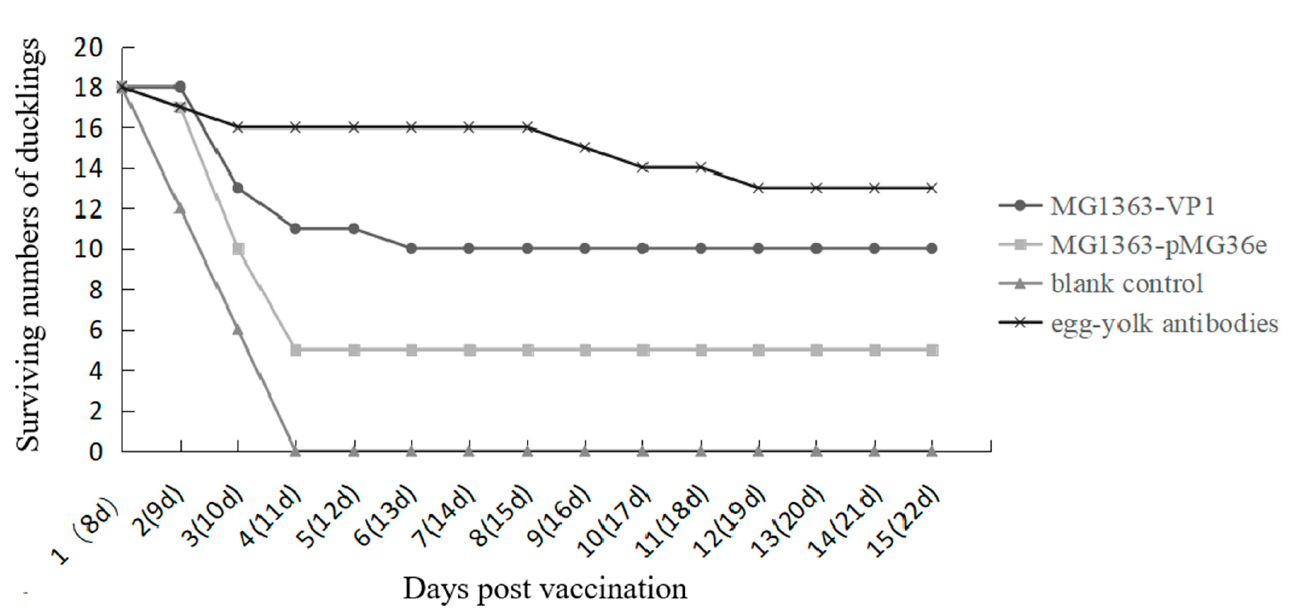
Figure 5. Detection of immune responses in serum or intestine samples of ducklings. ★ p < 0.05; ★★ p < 0.01; ★★★ p < 0.001.